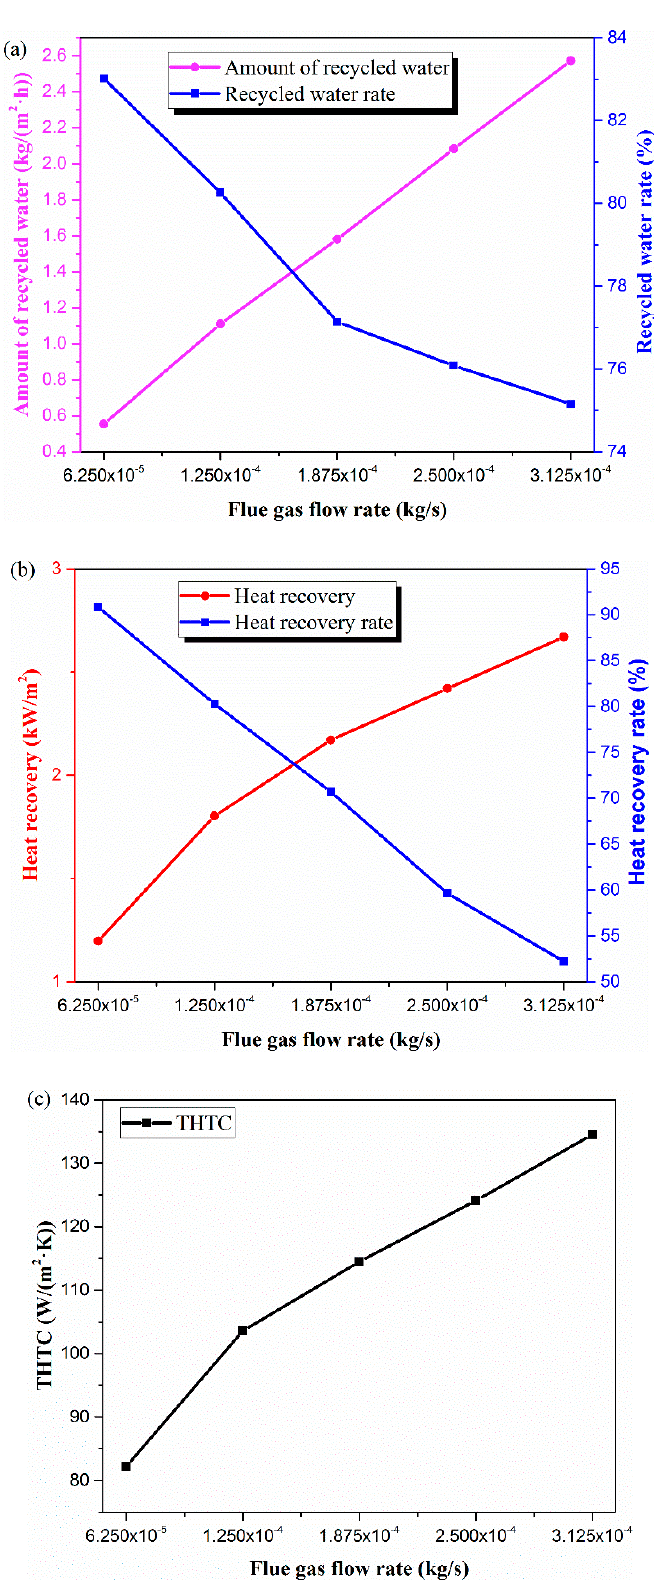
Figure 3. Effect of flue gas flow rate on ( a ) water, ( b ) heat, and ( c ) total heat transfer coefficient (THTC ) . (Experimental conditions: flue gas temperature 50 °C, water coolant flux 1.664 × 10 − 2 kg/s, water coolant temperature 20 °C).